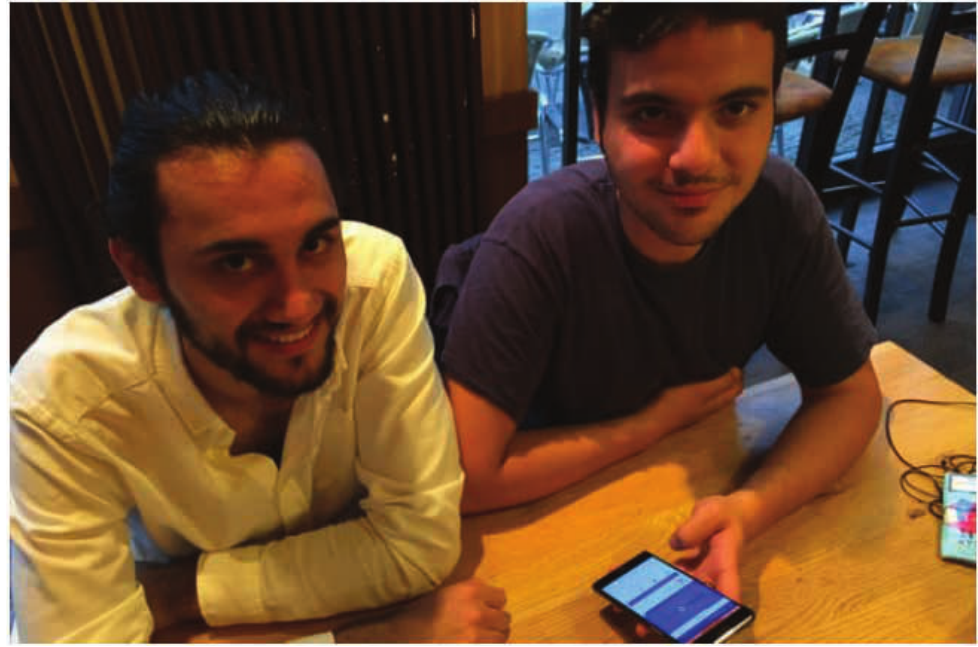
Figure 7: Munzer Khattab (left) and Ghaith Zamrik are on a mission to simplify German bureaucracy. Photograph: Philip Oltermann/the Guardian (GUA), https://www.theguardian.com/world/2016/aug/05/syrian-refugees-app-navigating-german- bureacracy-bureaucrazy (date of last access: